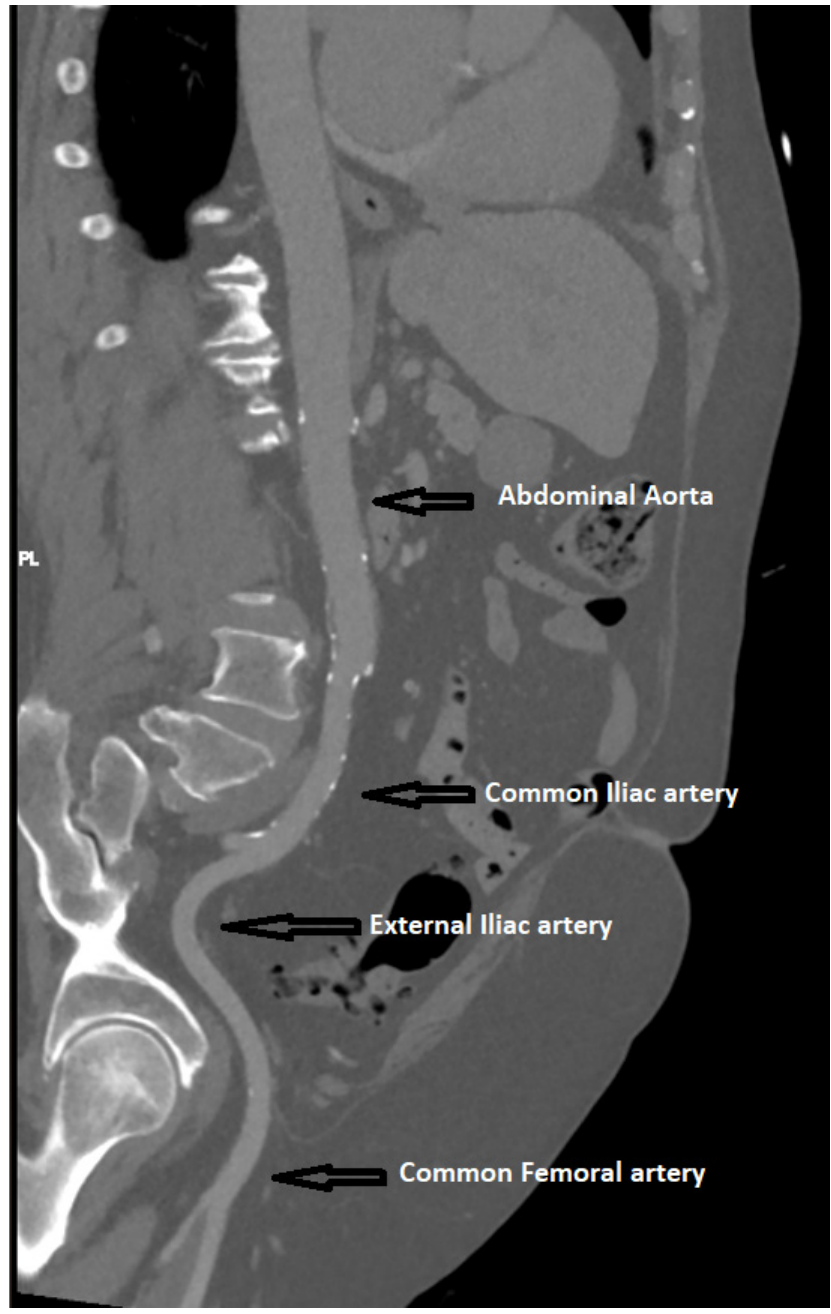
Figure 4. measurement of peripheral arteries upon MDCT. Figure 4. Measurement of peripheral arteries upon